Question: Write a caption explaining this figure to a reader.
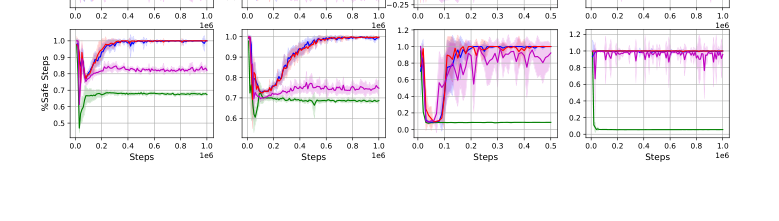
Answer: Bullet Safety Gym Results - Reward and Safety Performance